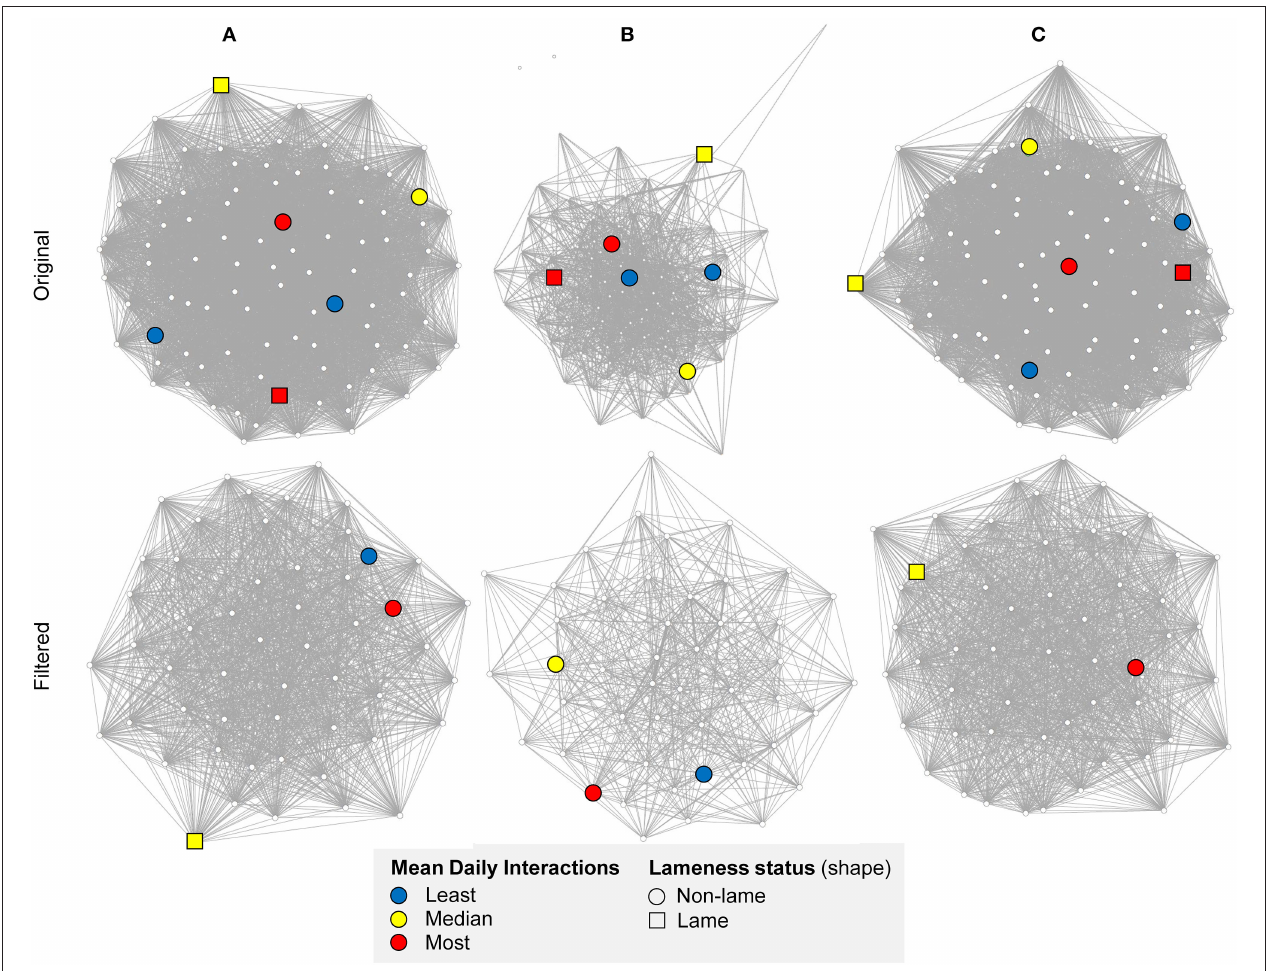
FIGURE 2 | Undirected original and filtered (by mean degree) networks on a randomly chosen day, 01/10/2014, in (A) the full barn, (B) feeding zone, and (C) non-feeding zone, showing mean daily interactions between cows ( n = 92 in original networks). Thicker edges indicate a higher number of daily interactions. The Fruchterman-Reingold layout algorithm was used to determine the node positions; unconnected vertices are repelled. The highlighted illustrative subset of cows correspond, respectively to the least (blue, cow ID = 3124 and 3317), median (yellow, cow ID = 3132 and 635), and most (red, cow ID = 2273 and 2266) mean daily interactions, with squared nodes representing lame cows. A clearer network structure is shown after filtering, with a more uniform distribution of interactions in the main barn and the non-feeding zone in comparison to the feeding zone. Created in RStudio using the “vegan” package ( 68, 69,